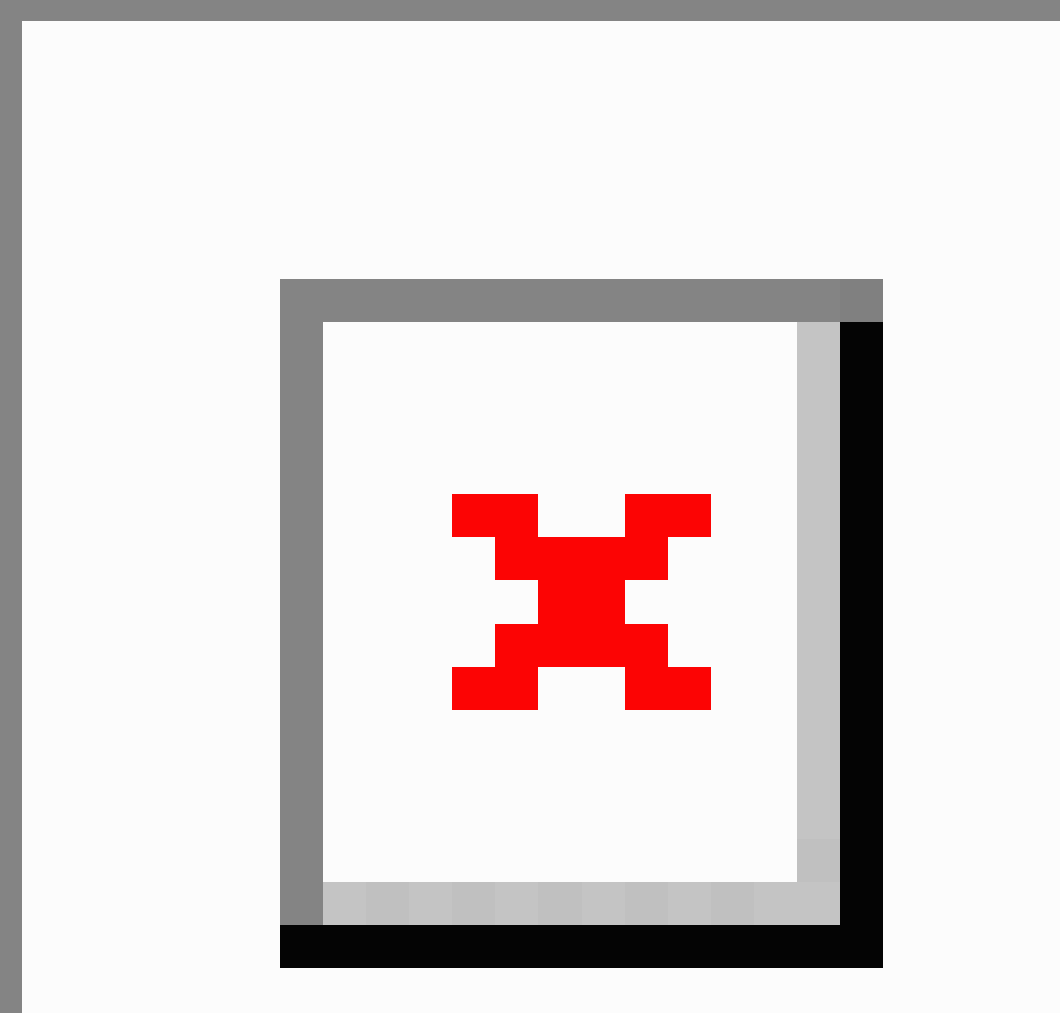
Figure 3. Changes in patient activation scores within groups starting at different levels of patient activation (n=137).